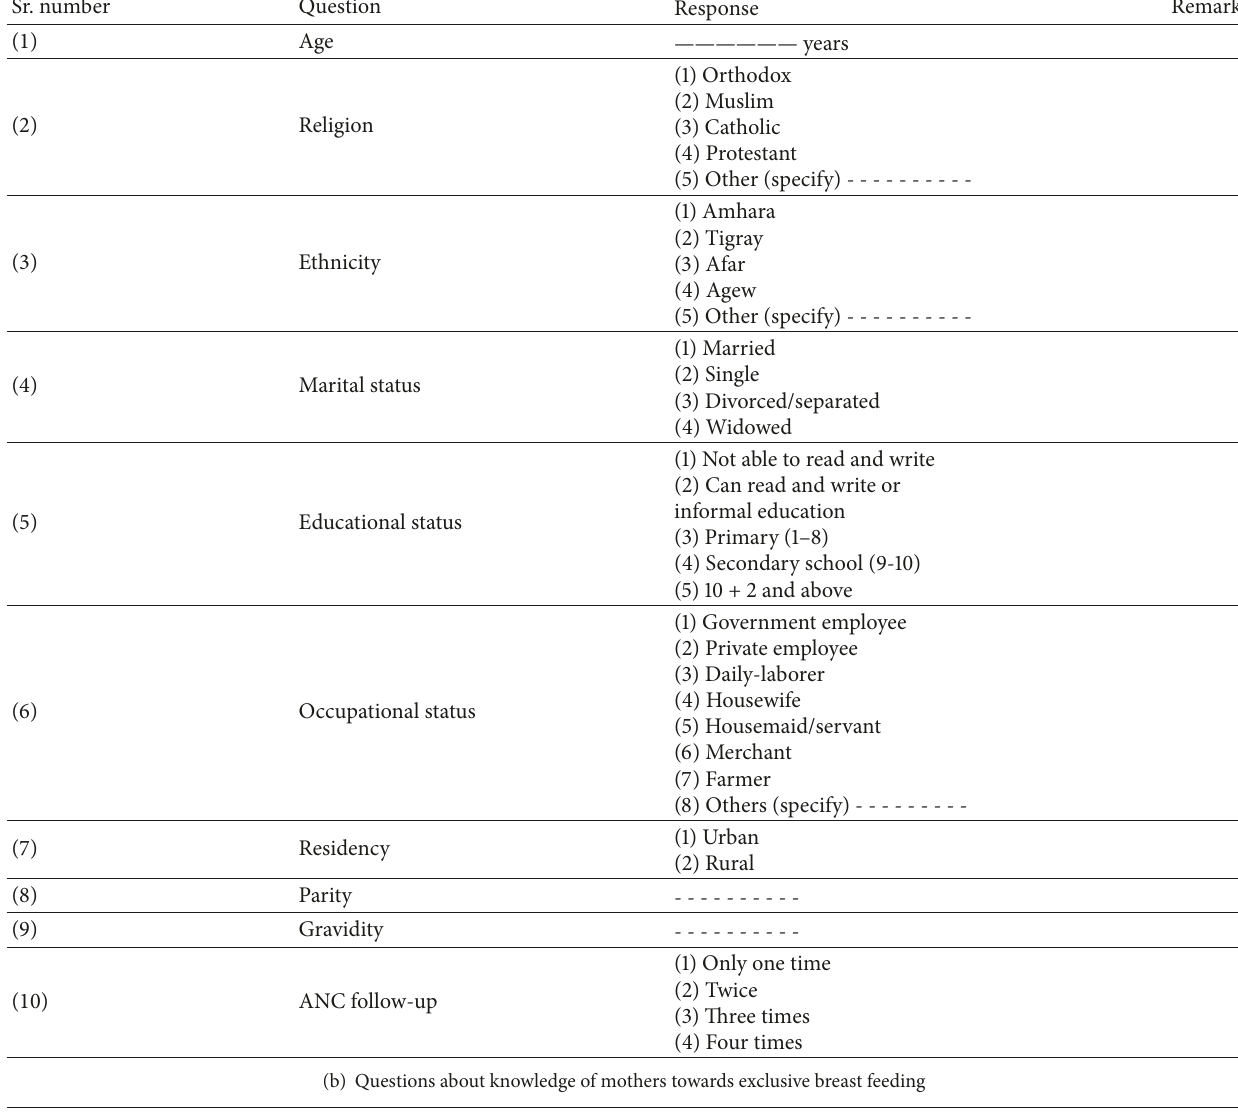
Table 4: Questionnaire used to collect the research